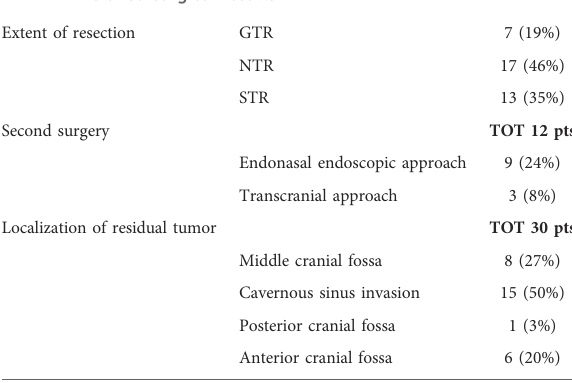
PA, pituitary adenoma. Silent: non-functioning pituitary adenomas showing staining for a pituitary hormone at immunohistochemistry.